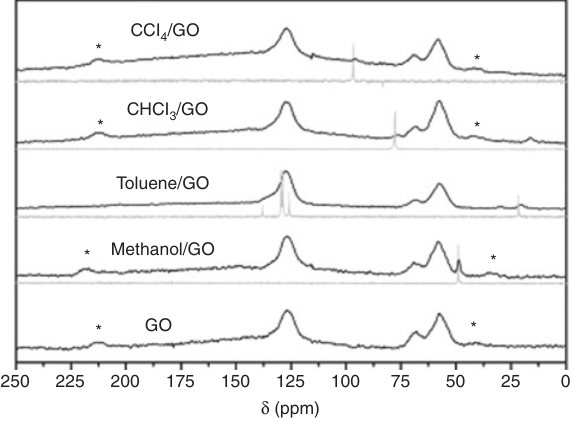
Figure 2: 13 C NMR spectra of representative retained-solvent GO and non-treated GO (black line). The corresponding solvent spectra are shown in grey color. (*) Spinning side bands [38].